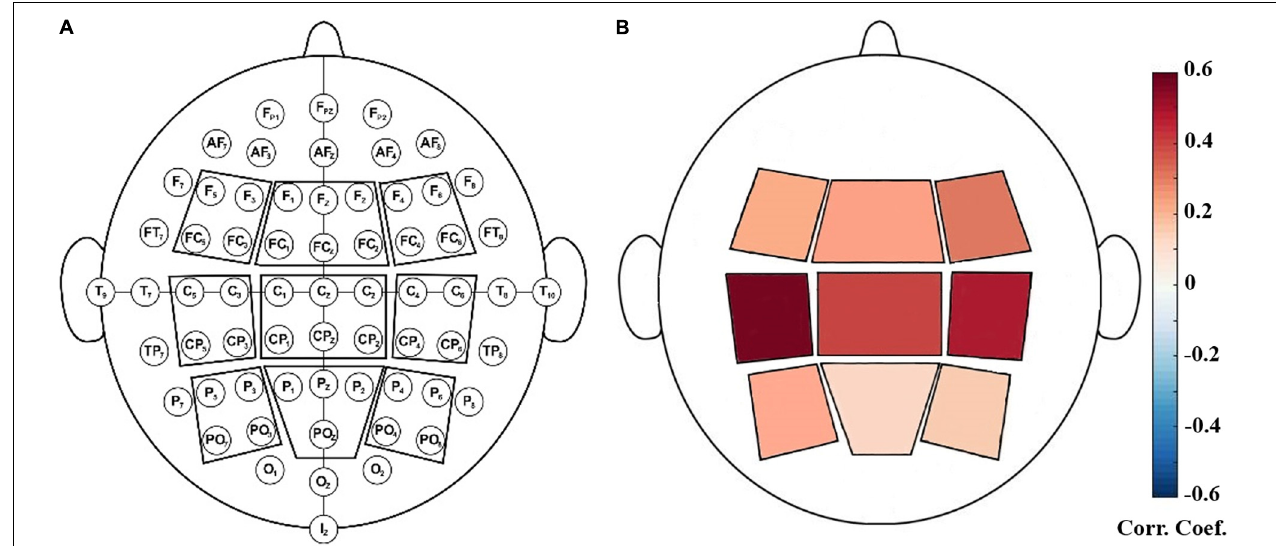
FIGURE 2 | (A) : Illustration of defined EEG-scalp regions of interest (ROI). (B) : Positive correlation between SMR power at rest (baseline) and NFB learning index LI. The ROI outlined in red contained C5, C3, CP5, CP3 and it showed significant correlation with LI ( P < 0.05, FDR-corrected).